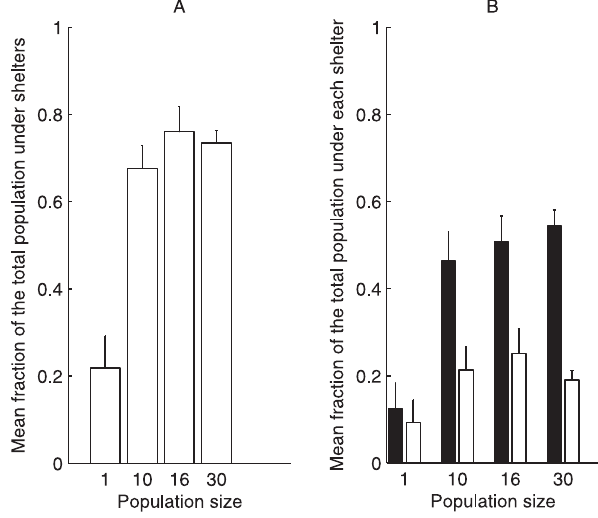
Figure 1. Settlement under shelters according to population size. (1 (n=32), 10 (n=30), 16 (n=30) and 30 cockroaches (n=25)) at t=180 min. (A) Mean fraction of the total population under both shelters (Kruskal-Wallis test: KW=23.6, p , 0.0001; Dunn’s Multiple Comparisons Test: paired comparison including 1 individual p , 0.01; for other comparisons p . 0.05); (B) Mean fraction of the total population under each shelter: dark (black) and light (white) (Kruskal- Wallis test for dark shelter: KW=31.17, p , 0.0001; Dunn’s Multiple Comparisons Test: paired comparison including 1 individual p , 0.001, for other comparisons p . 0.05). Error bars indicate S.E.M.